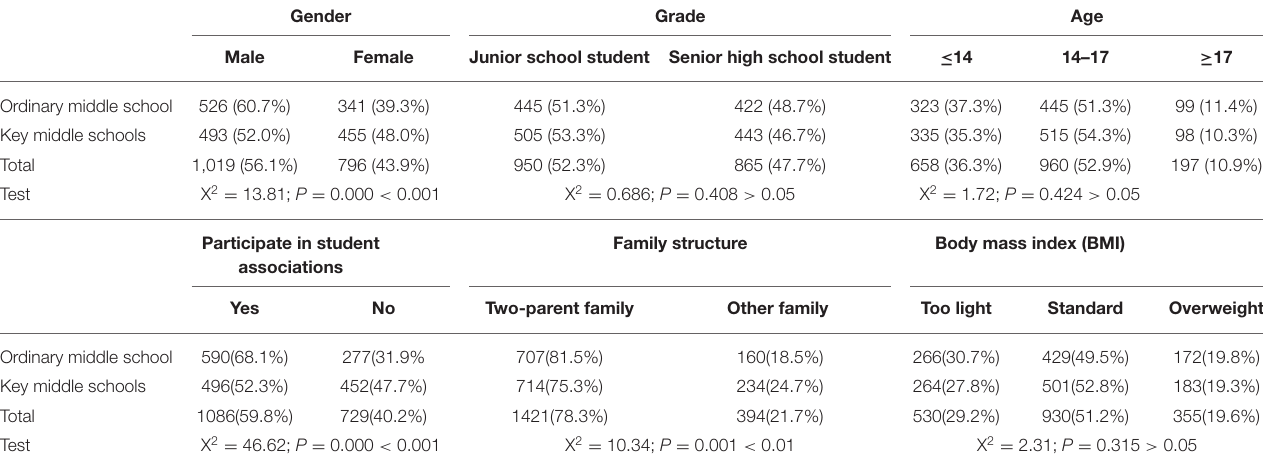
TABLE 1 | Descriptive statistical analysis of personal background information of respondents ( N =